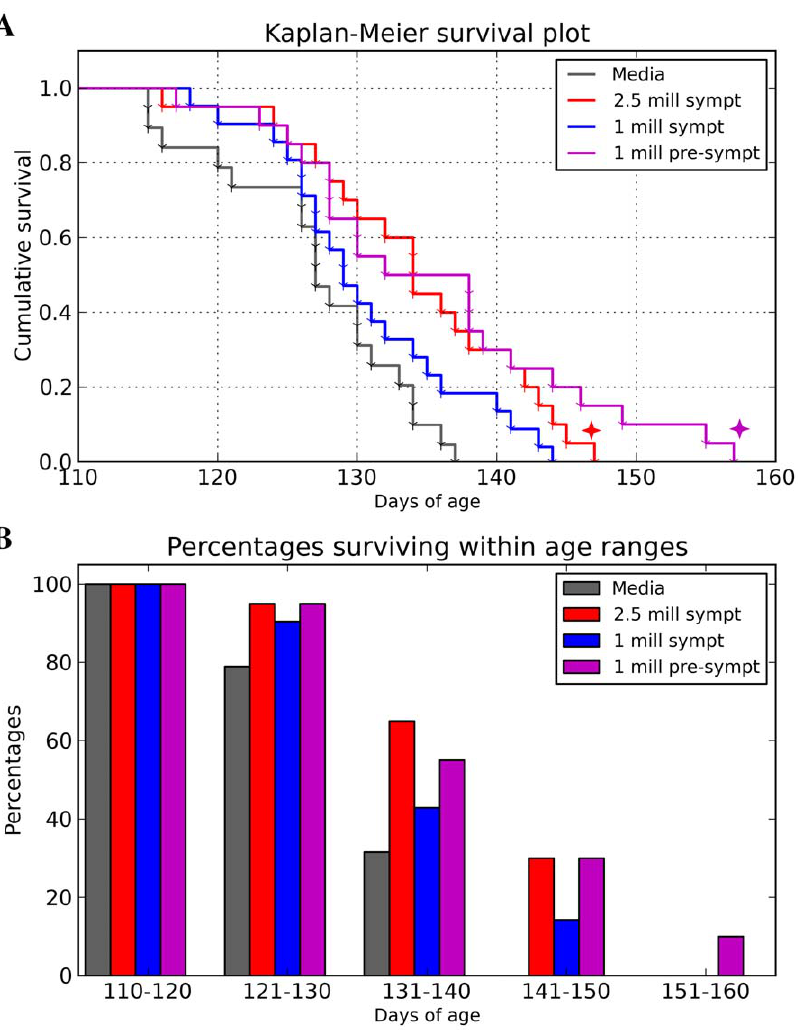
Figure 1. Effect of multiple MNC hUCB cell administrations on lifespan of G93A mice. ( A ) Kaplan-Meier survival curves for G93A mice receiving 2.5 6 10 6 ( Gr 1 ) or 1 6 10 6 ( Gr 2 ) cells at symptomatic disease stage and 1 6 10 6 ( Gr 3 ) cells pre-symptomatically. Control group was Media- injected mice ( Gr 4 ). Significant